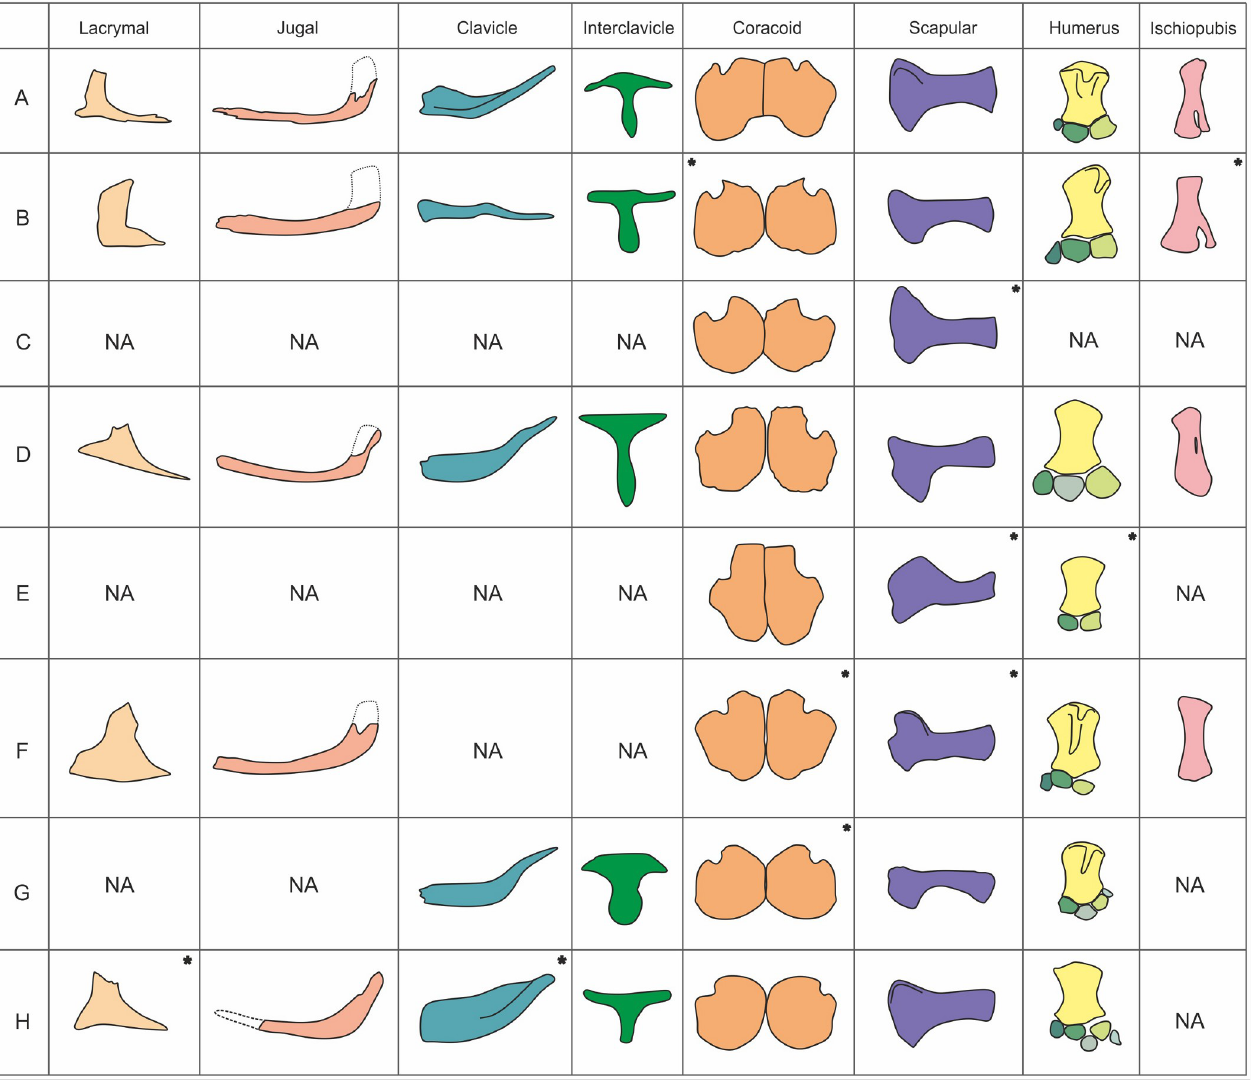
Fig 21. Comparisons with other Late Jurassic and Early Cretaceous ichthyosaurs. A, Thalassodraco etchesi , MJML K1885, B, Undorosaurus gorodischensis , PMO 214. 578, C, Acamptonectes densus , GLAHM 132588, D, Ophthalmosaurus icenicus , NHMUK PV R2137, E, Nannopterygius enthekiodon , NHMUK PV 46497, F, Sveltonectes insolitus , IRSNB R269, G, Grendelius alekseevi , YKM 56702, H, Arthropterygius chrisorm , jugal, clavicle and scapular from specimen CCMGE 17-44/13328, interclavicle from specimen SGM 1573, coracoids and scapula from specimen CCMGE 3-16/13328, lacrymal from A . lundi PMO 222.654. ‘ � ’ indicating elements that have been mirrored for comparative purposes. Not to